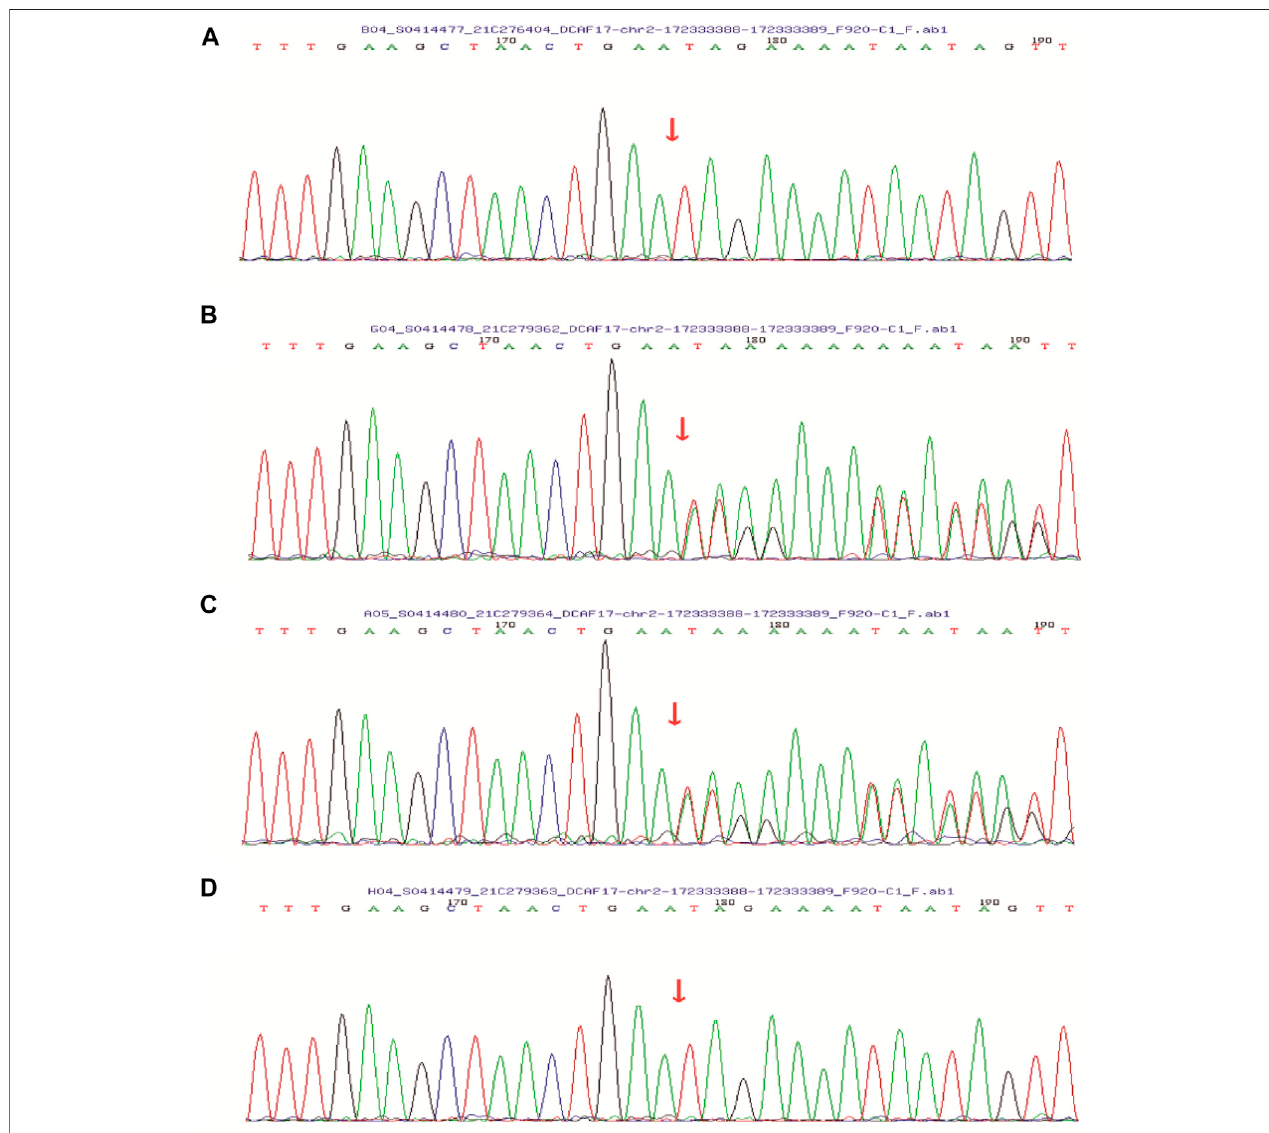
FIGURE 4 | Sanger sequencing showed that the patient ’ s (A) and her younger brother ’ s (D) DCAF17 harbored a homozygous mutation c.1111delA, p.(Ile371Term), while their father (B) and mother (C) were heterozygous for this mutation at this site.